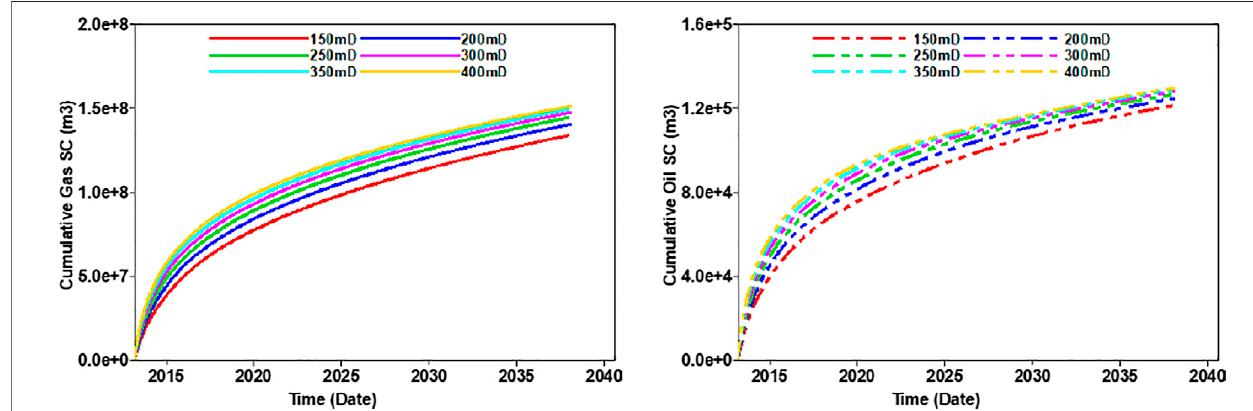
FIGURE 8 | Productivity of segmental fractured horizontal well with different fracture permeability.